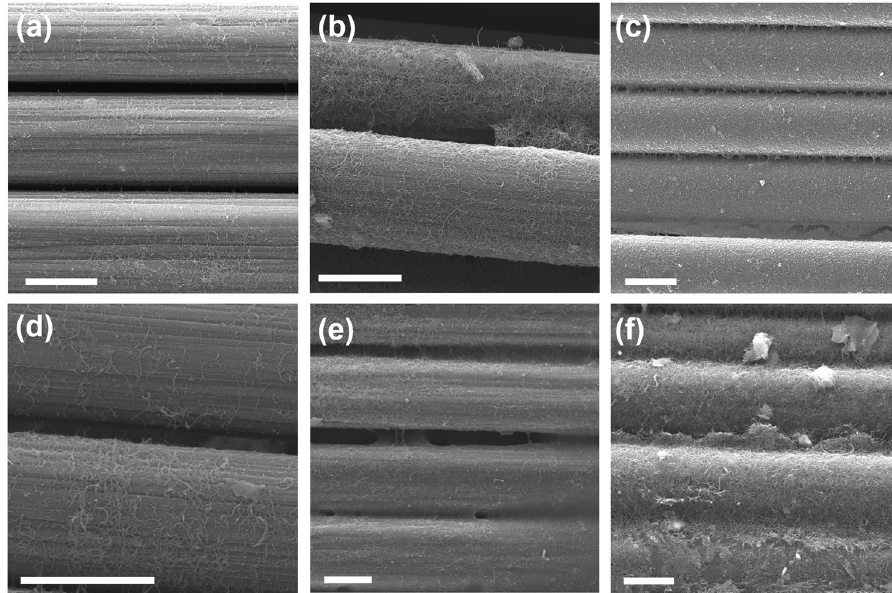
Figure 3: SEM images of carbon fi ber morphology with various EPD duration time: g - CNTs ( a ) – ( c ) and C - CNTs ( d ) – ( f ) for 1, 2, and 5 min, respectively. The concentration and applied voltage strength are 0.1 mg/min and 10 V/cm, respectively. All the scale bar is 5